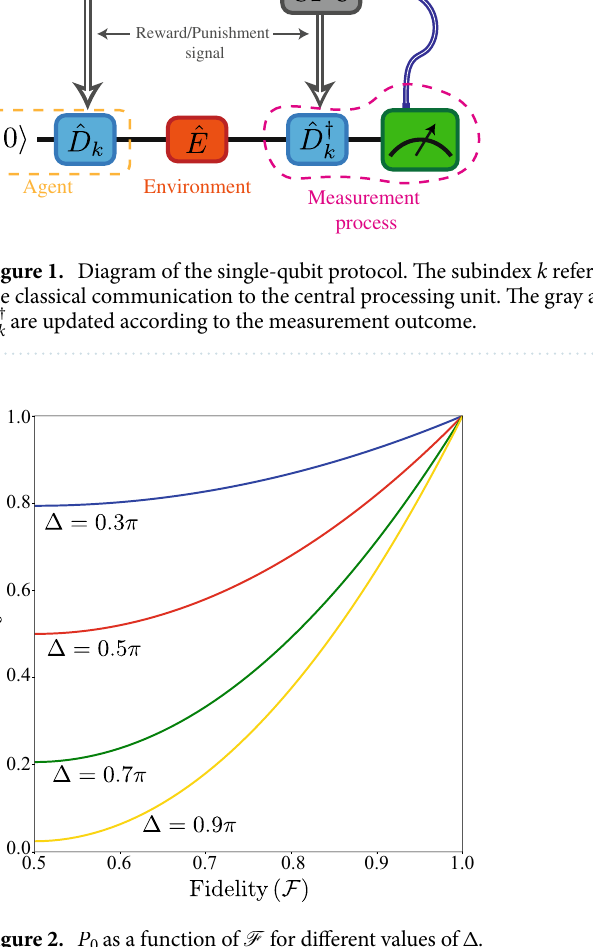
Figure 2. P 0 as a function of F for different values of (cid:31)